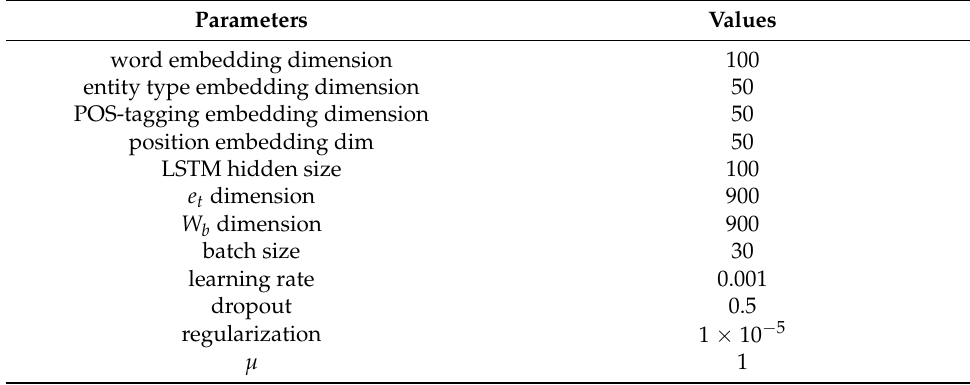
Table 2. Hyper-parameter